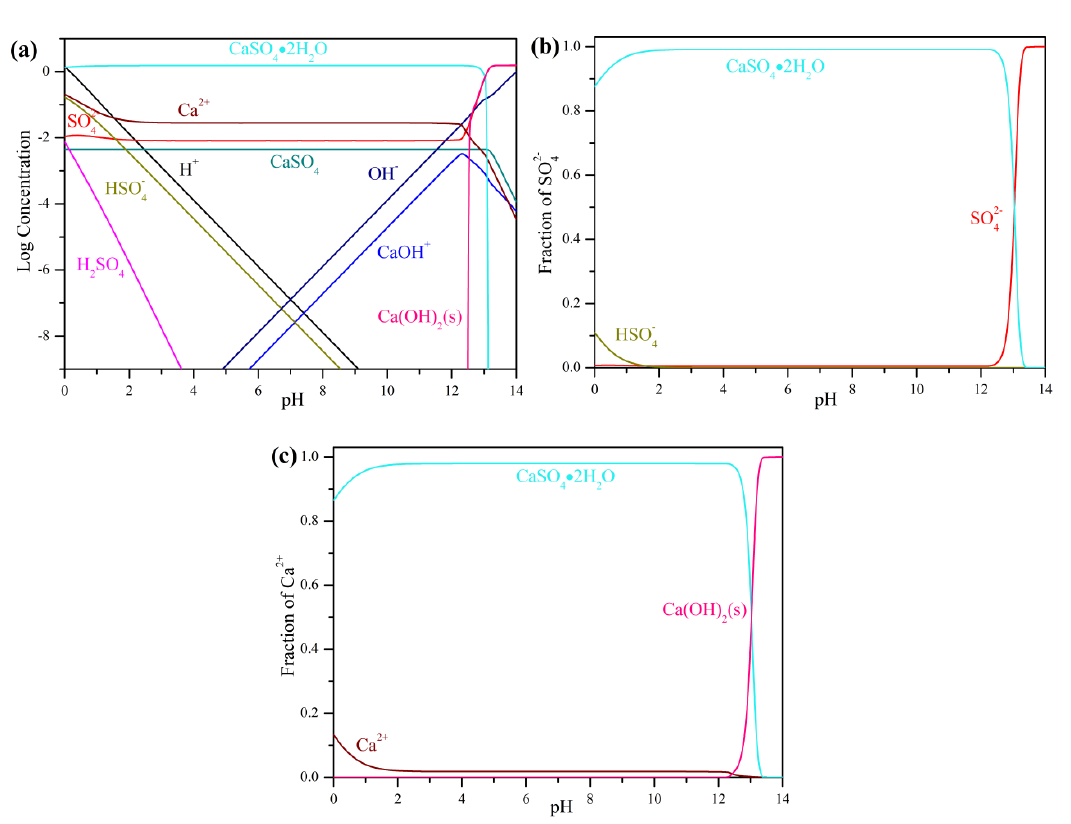
Figure 4. Calculated species distributions of 1.53 M SO 42− reacting with 1.55 M Ca(OH) 2 at different pH: ( a ) with log concentration vs. pH; ( b ) with fraction of sulfate vs. pH; ( c ) with fraction of calcium vs. pH.